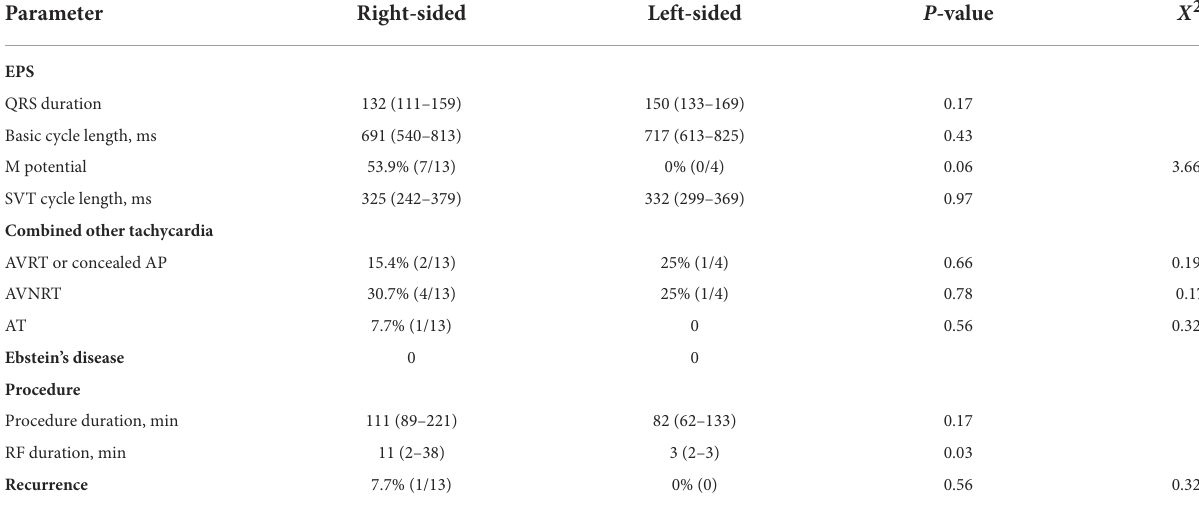
TABLE 2 Electrophysiological data from 17 patients with Mahaim-type accessory pathways who underwent electrophysiological